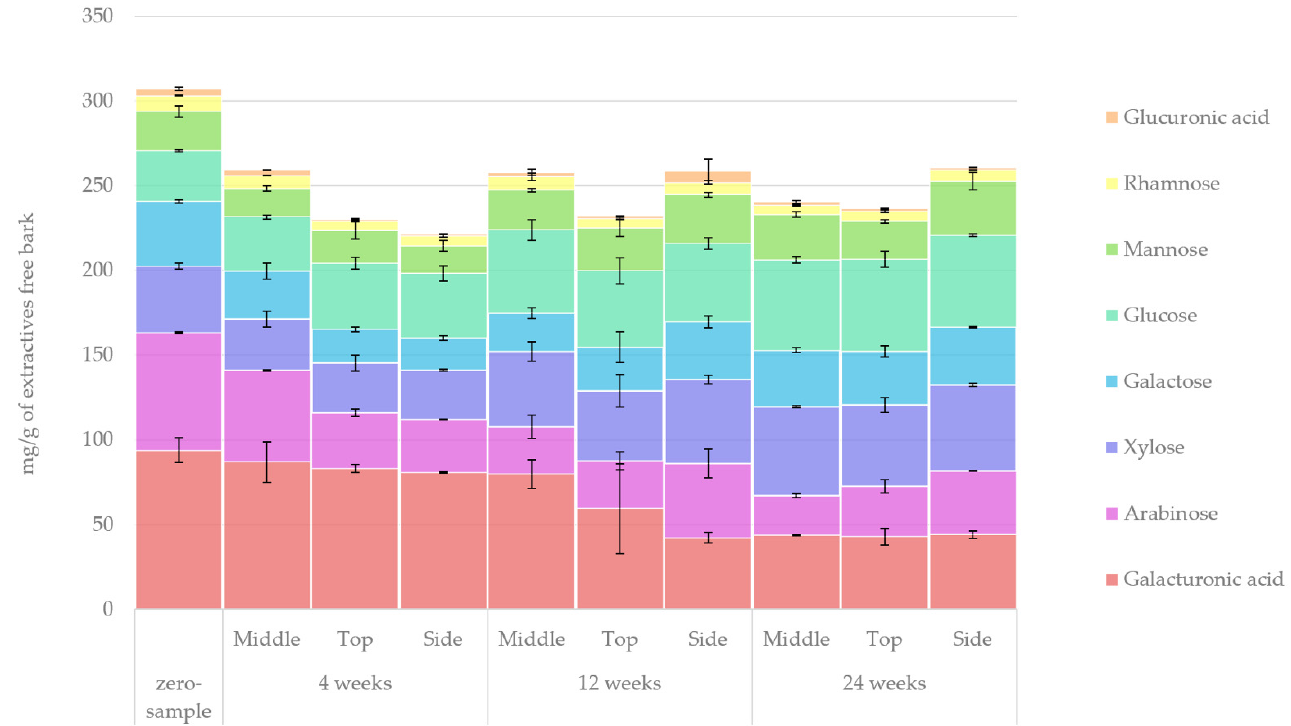
Figure 16. Quantified amounts of hemicellulosic carbohydrates in the extractive-free bark samples under normal pile storage.